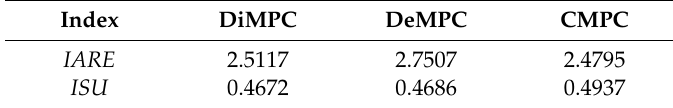
Table 4. Performance indexes for IARE and ISU.